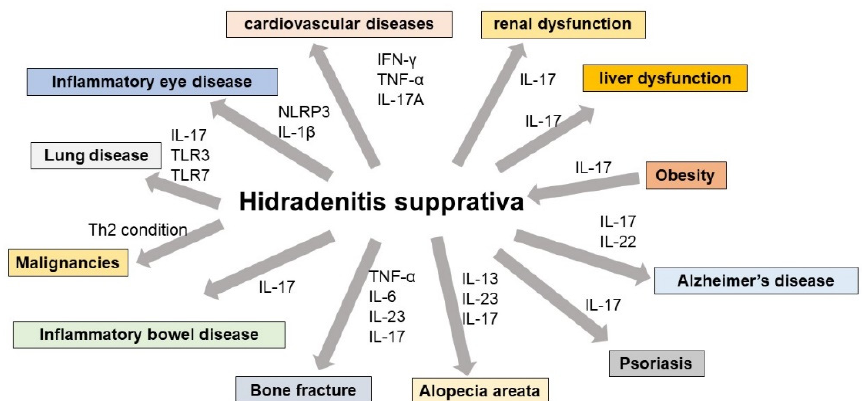
Figure 2. The influence of HS-mediated inflammatory response in systemic organ dysfunction. HS- mediated inflammation contributes to the development of systemic organ dysfunctions. HS lesional skin drives various inflammatory cytokines which exacerbate inflammatory responses in other organs. This figure shows the HS-related risk of systemic organ dysfunction and associated inflammatory cytokine for the development of these pathogeneses.